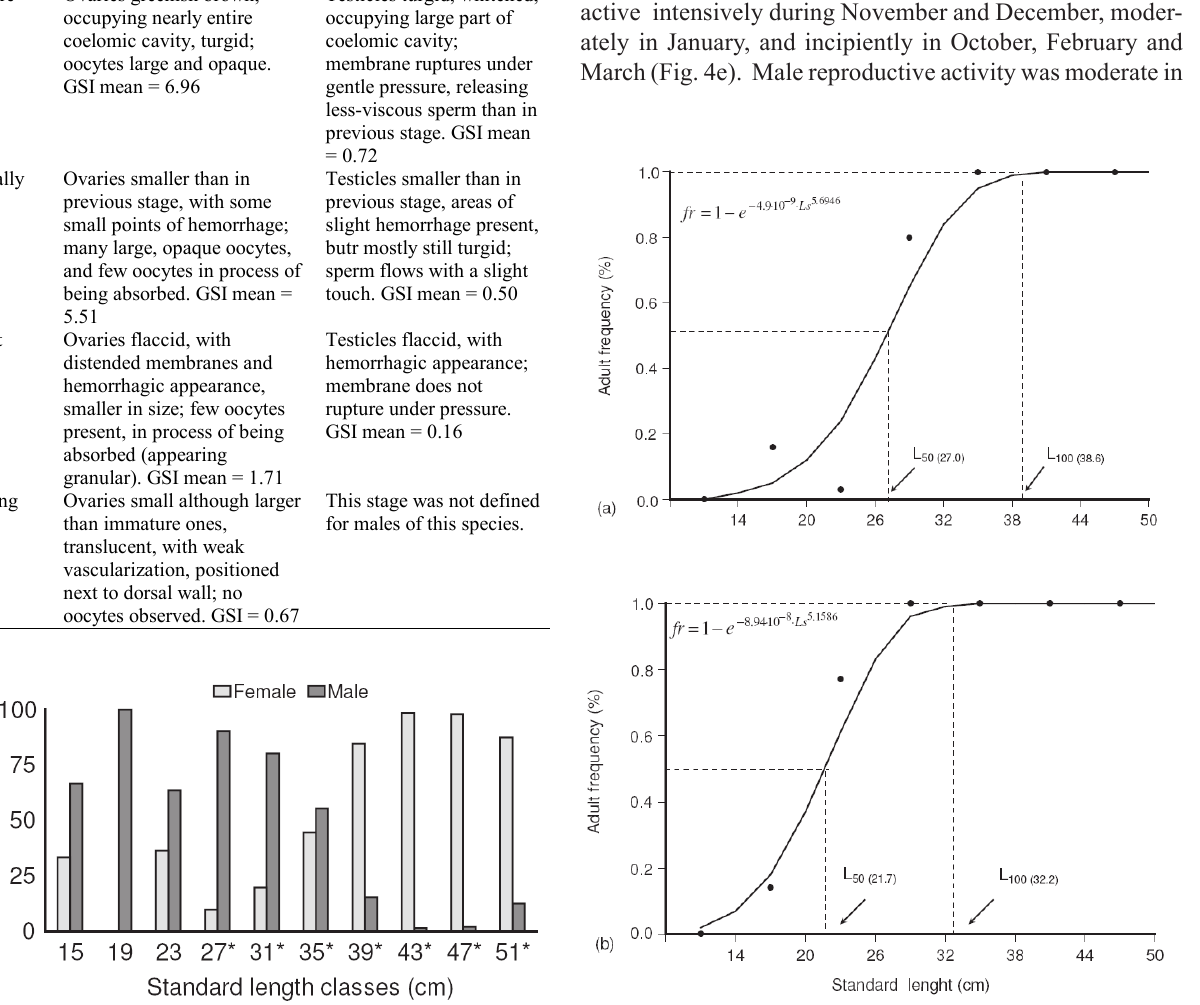
Fig. 2. Distribution of males and females of Rhaphiodon vulpinus , by standard length class. Asterisks indicate sig- nificant differences in sex